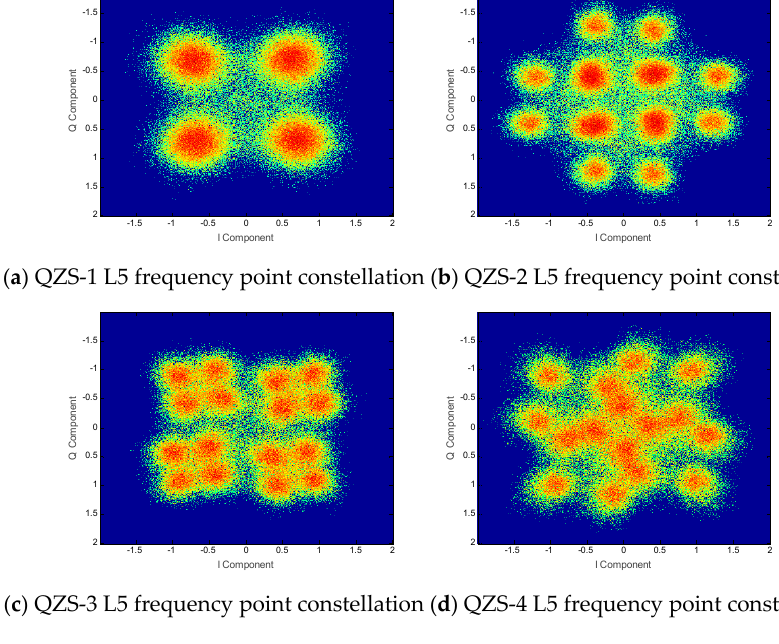
Figure 8. QZSS satellite L5 frequency constellations.